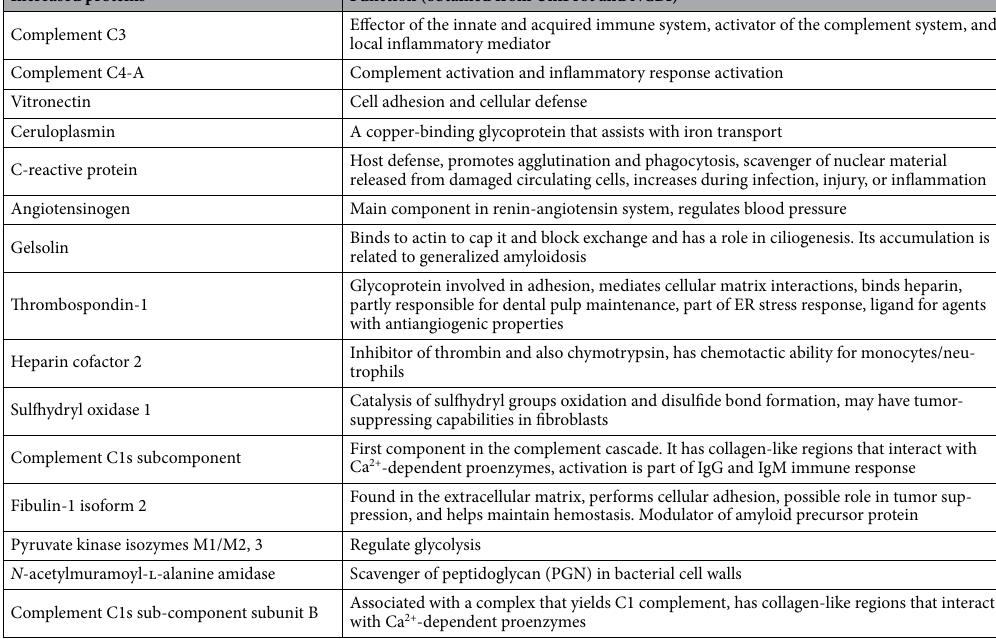
Table 1. Functions of a select group of increased proteins identified in the red tide group. a Proteins were selected that had average fold change ratios > 1.2.